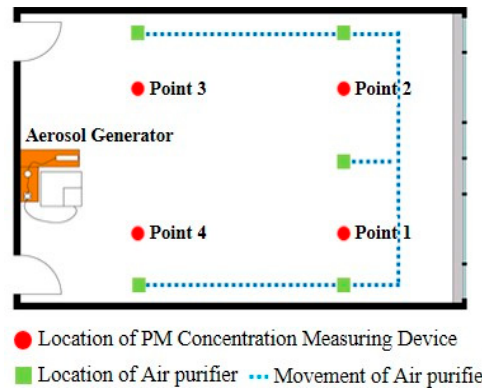
Figure 13. Location of the air purifier at each time and moving path from the previous location (Zone Controlling Method). 4.2. Experiment Results Figure 14 shows changes in the PM 2.5 concentration by measurement point according to the operation of the air purifier that tracks occupants in real-time. The PM2.5 concentrations were compared and analyzed at P 5 (Point 5), which is considered as the breathing zone of occupants and continuously received purified air currents discharged from the air purifier and other measurement points. The PM 2.5 concentrations at all measurement points had increased after 10 min from the start of the measurement and reached about 100 μ g/m 3 at P 1, P 2, and P 4 at 40 min. The upward slopes of P 5 and P 3, which were closest to the discharge outlet of the air purifier, were relatively low compared to those of other points and showed concentrations of 40 μ g/m 3 and 55 μ g/m 3 , respectively. During the overall experiment time, the average concentration at